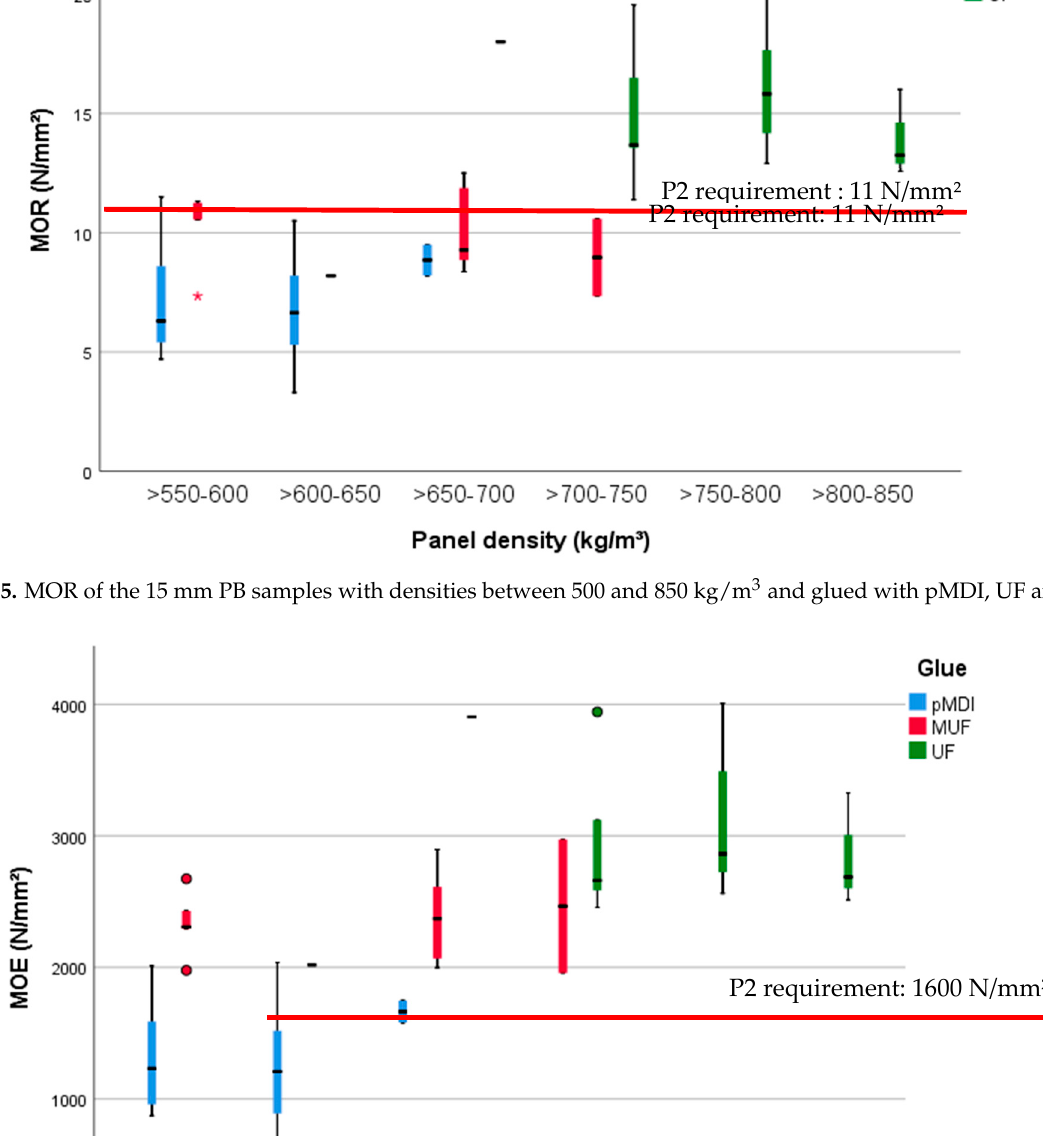
P2 requirement: 1600 N/mm²